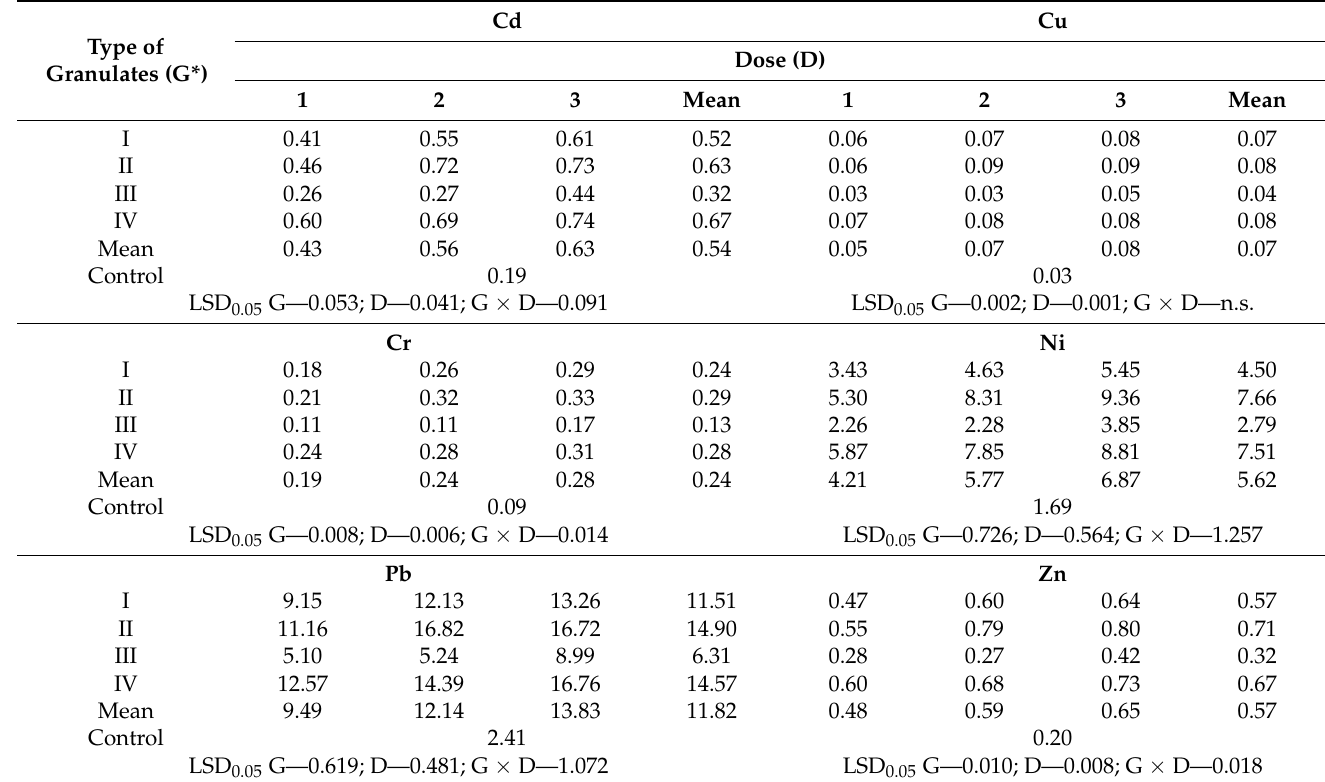
Table 8. Uptake of Cd, Cu, Cr, Ni, Pb and Zn in triticale (in mg · kg − 1 DM) to pot under the effect of sludge-ash